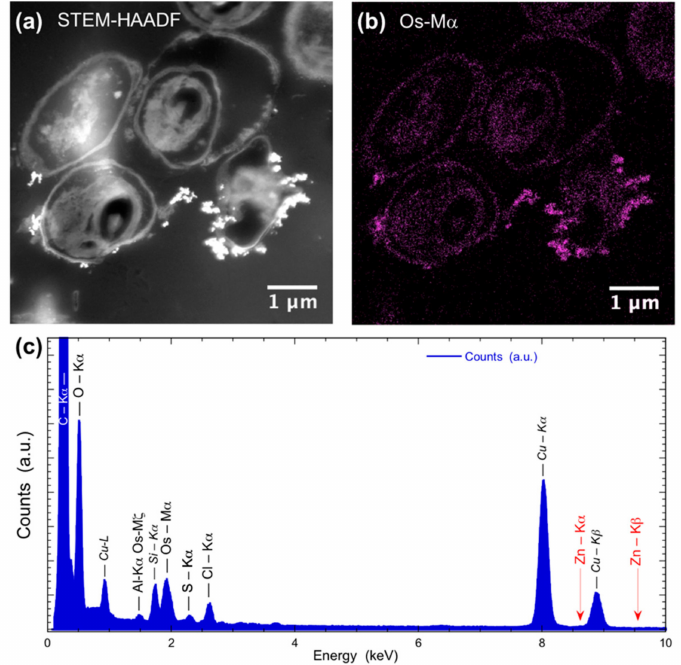
Figure 11. ( a ) STEM-HAADF and ( b ) STEM-XEDS images of Chlorella vulgaris ultrastructure after contact with ZnO nanoparticles (10 –3 M) in Seine river. Bright areas within the cell are due to the accumulation of contrasting agent OsO 4 . ( c ) XEDS spectrum showing the absence of